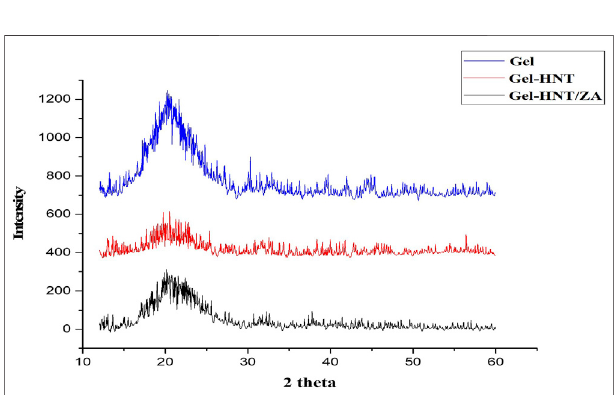
FIGURE 4 | X-ray diffraction pattern of the Gel, Gel-HNT and Gel-HNT/ ZA scaffolds.